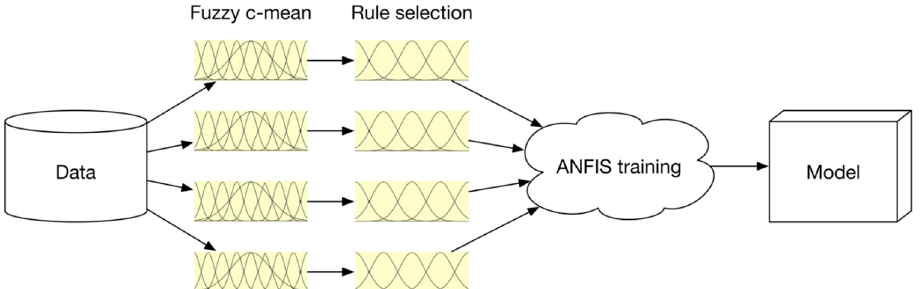
Figure 5. Flow diagram of the adaptive-network-based fuzzy inference system (ANFIS) based reclassification system.